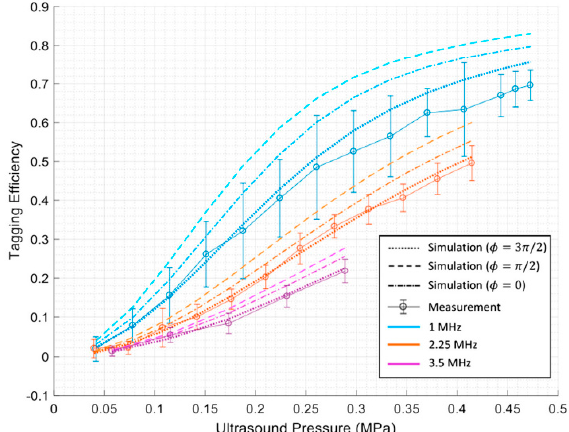
Figure 2. The results of Huang et al. [17] indicating tagging efficiency vs. US pressure and frequency. Gunther et al. [28] developed a MC model using the CUDAMCML code, a MC model of steady − state light transport in multi − layered tissues based on NVIDIA’s Compute Unified Device Architecture (CUDA), to study the contrast − to − noise ratio (CNR) of